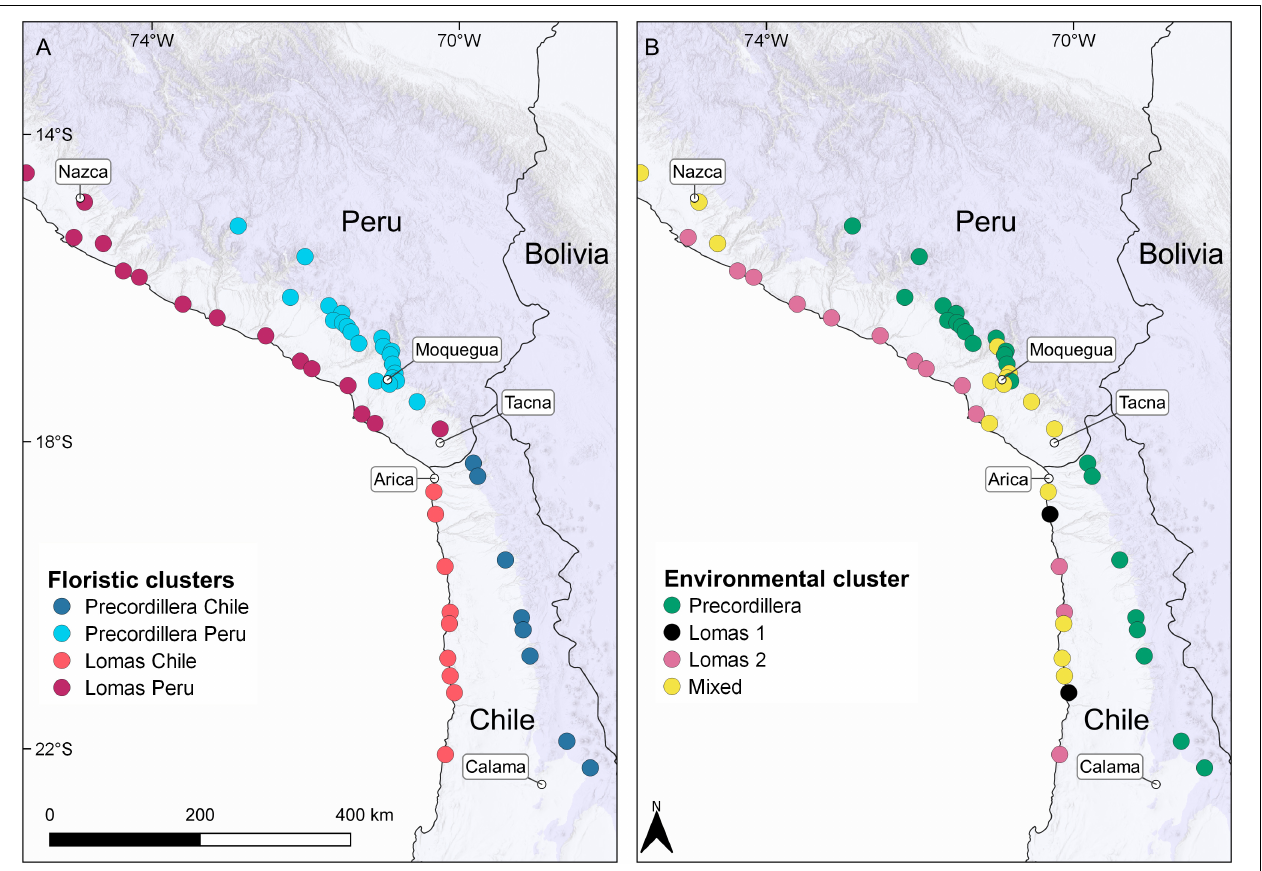
FIGURE 6 | Overview of Locations color coded according to the results from cluster analyses (UPGMA) of (A) floristic data and (B) environmental data. Maps were created in QGIS 3.14.16. Country layers were taken from Natural Earth (www.naturalearthdata.com). City layers were taken from MapCruzin (www.mapcruzin.com). Hillshade layer was taken from ESRI (Environmental System Research Institute [ESRI], 2020). Information on mean elevation of each raster cell (resolution: 30 s) was taken from GMTED2010 (Danielson and Gesch, 2011). For the interactive map see: